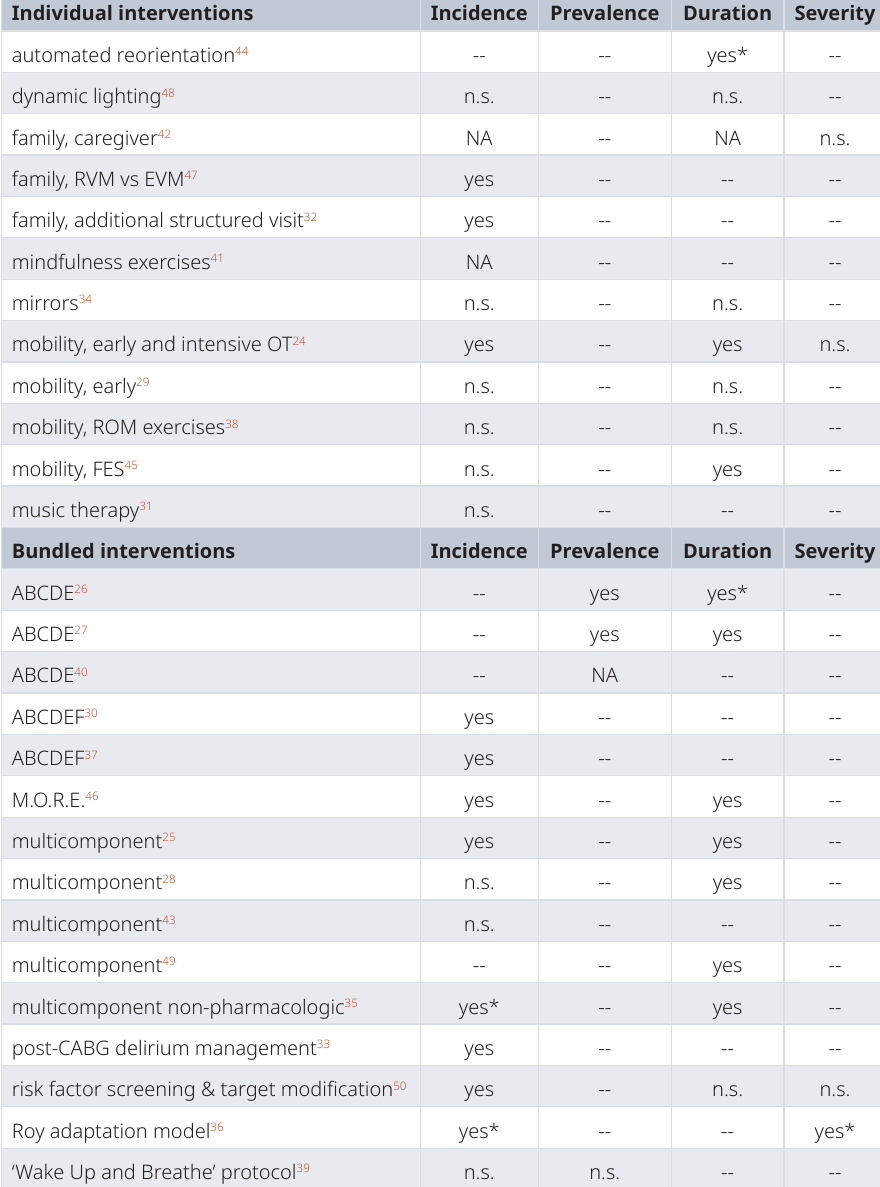
Table 2. Summary of delirium